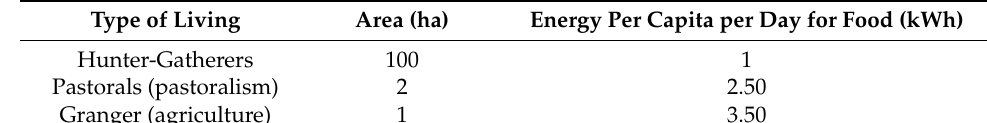
Table 1. Prehistoric human, different types of living, minimum area, and energy needs for food production (present data as order of magnitude) [75,76,79–87].